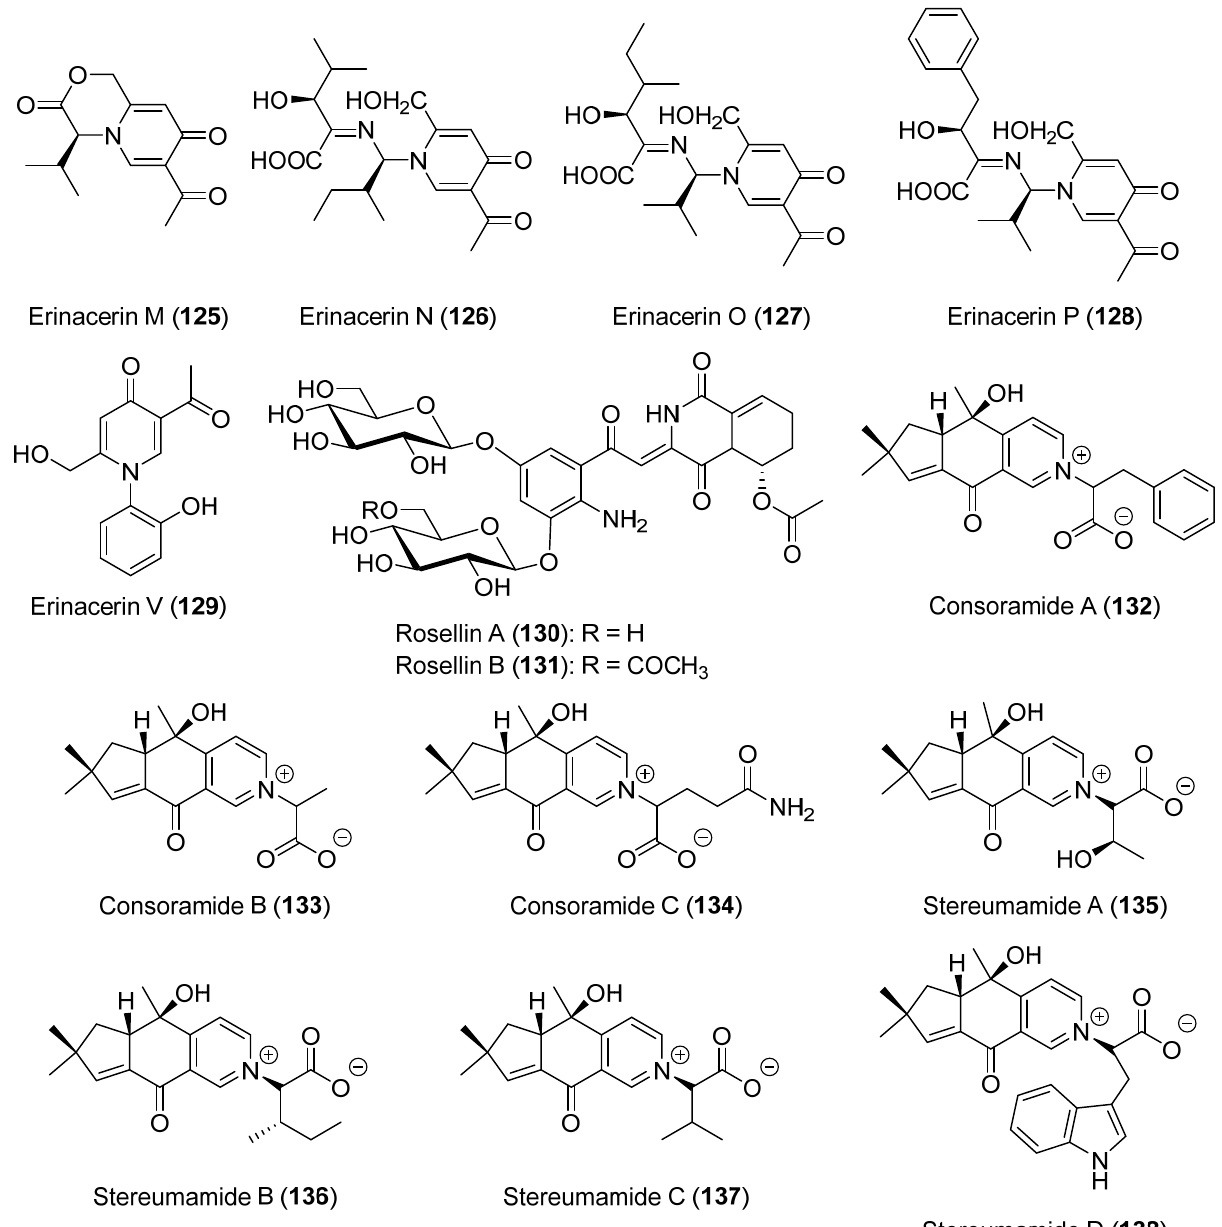
Figure 8. The structures of the miscellaneous alkaloids 125 – 138 .